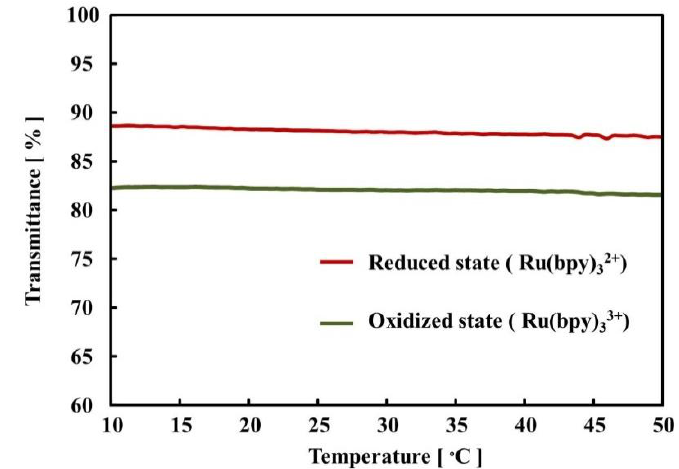
Figure 2. Temperature dependence of transmittance for poly(VP- co -Ru(bpy) under the different conditions of reduced Ru( Ⅱ ) (in Ce( Ⅲ ) solution) and Ru( Ⅲ ) (in Ce( Ⅳ ) solution)